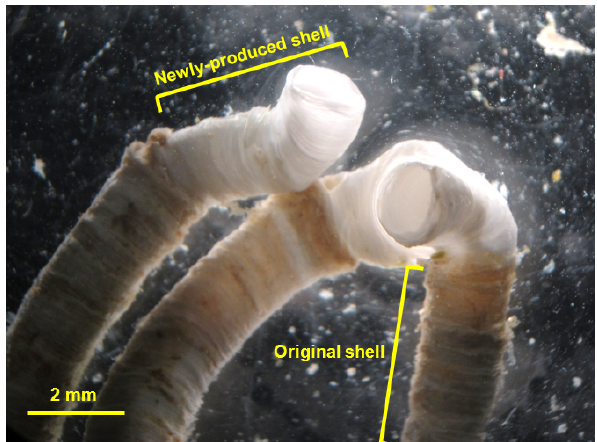
Figure 1. A micrograph showing the newly produced shell and orig- inal shell of H. diramphus , where the former is easily distinguished from the latter by the white color. The original shell appears slightly colored due to the biofilm (e.g., bacteria and algae) growing on the surface in the